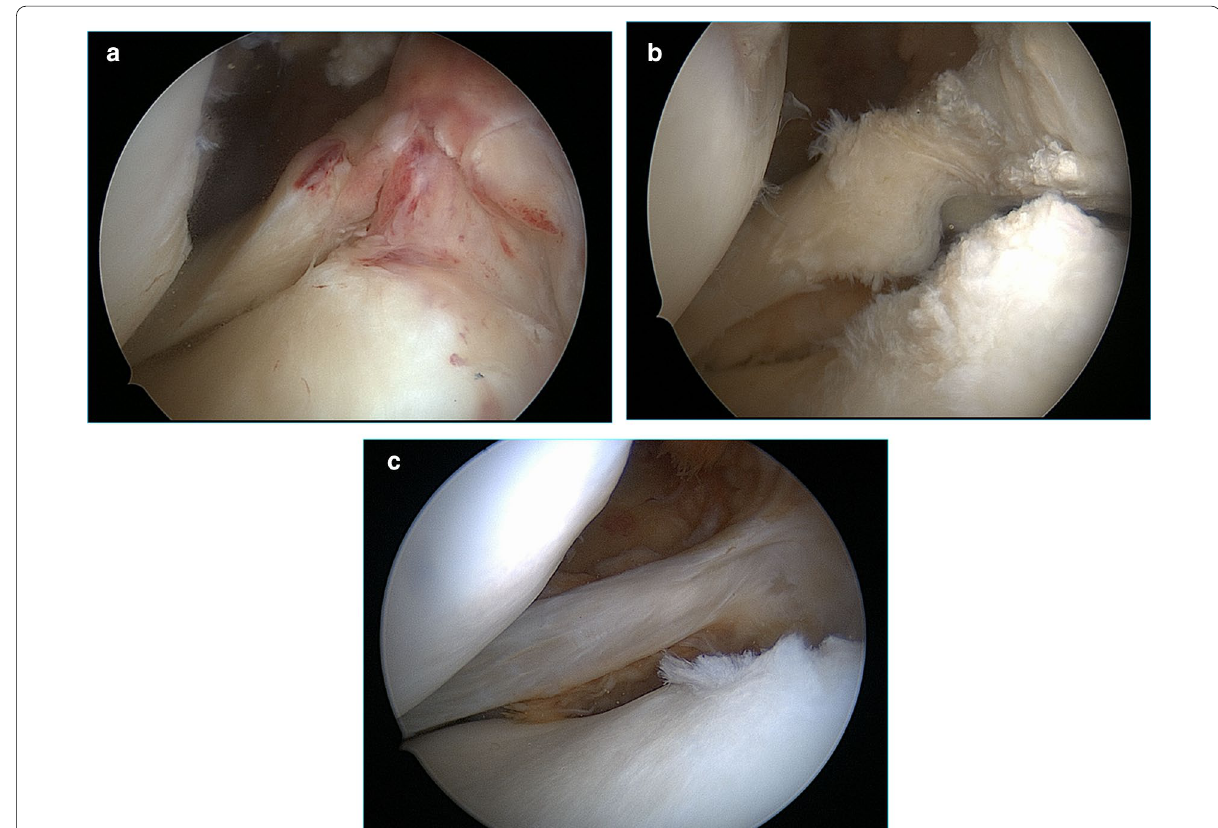
Fig. 1 Lateral meniscal root avulsion in the right knee from the anterolateral portal: a acute avulsion, b chronic avulsion, c inner loss